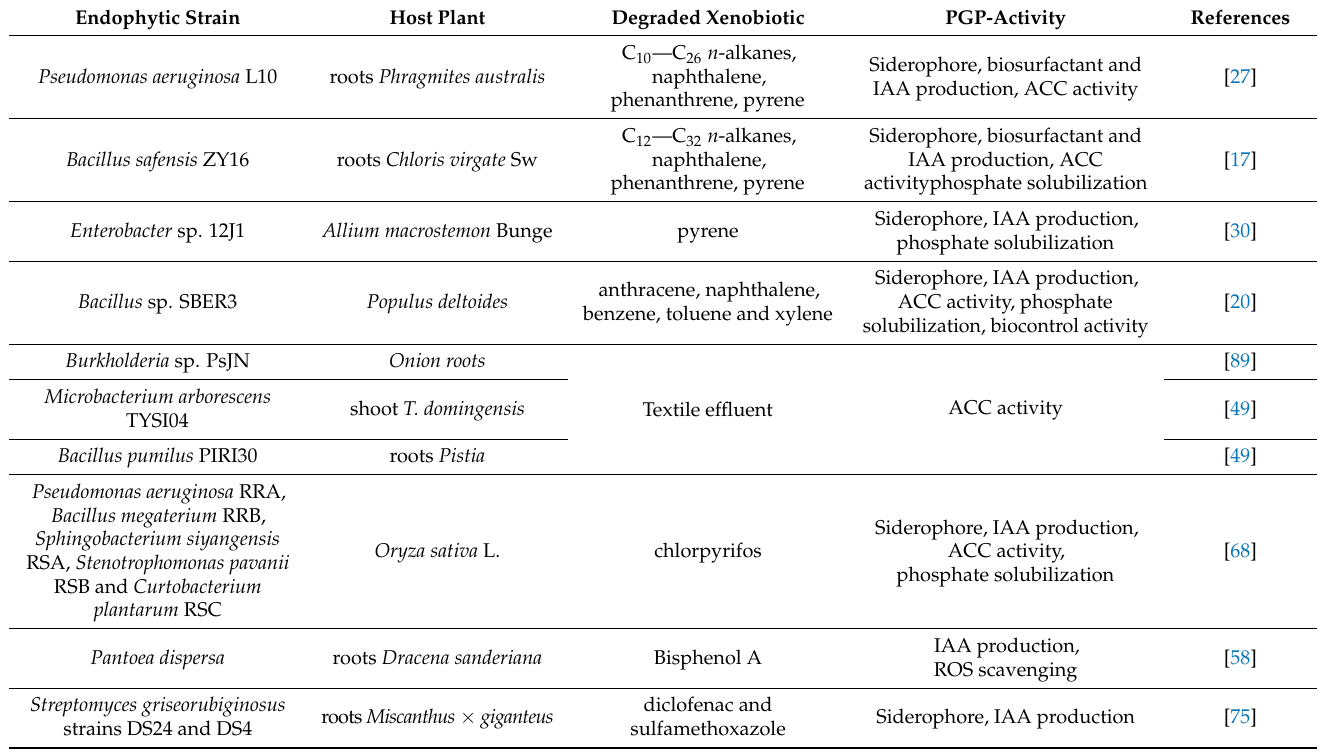
Table 1. Examples of interactions of PGP-endophytes with their host plants allowing for removal of selected